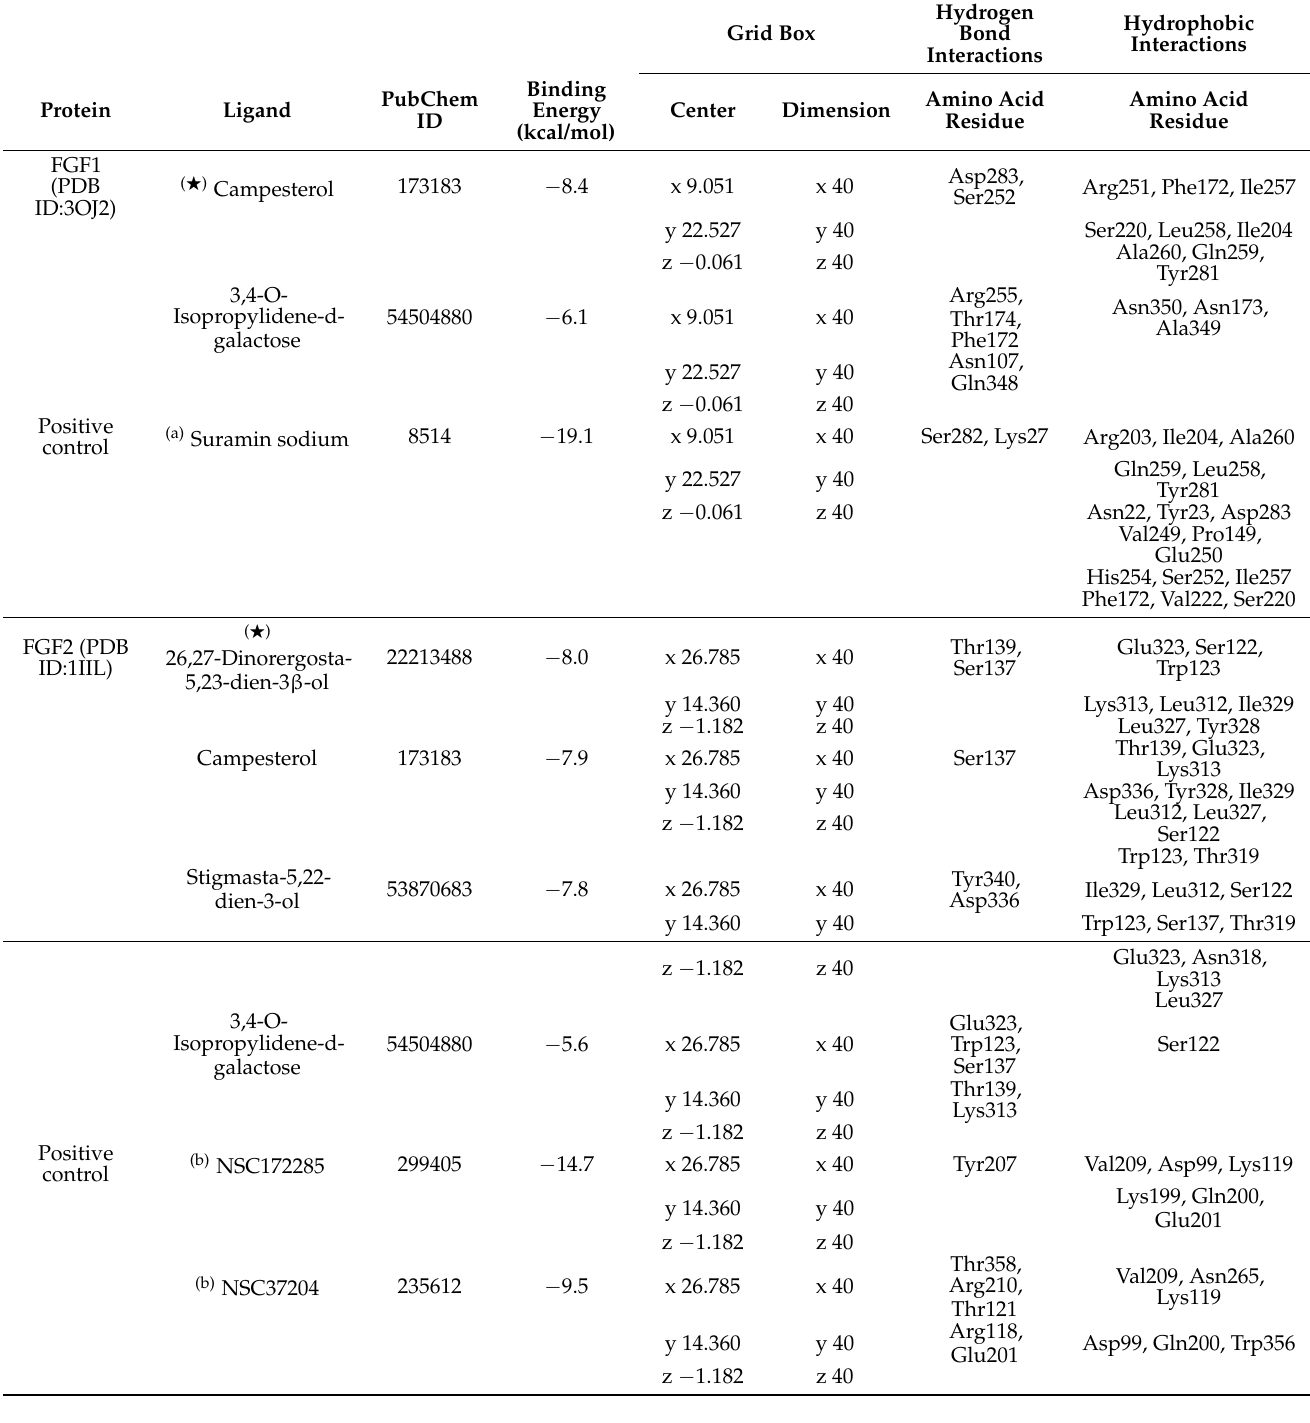
Table 6. Binding energy of ligands and positive controls on MAPK signaling